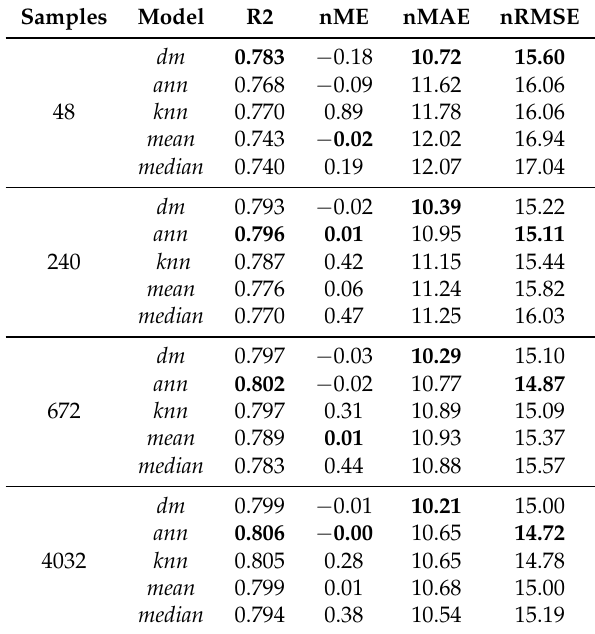
Table 2. Error measures of the forecasting models with different training set samples size, for turbine 2. The number of samples correspond to 2 days, 10 days, 4 weeks and 24 weeks of